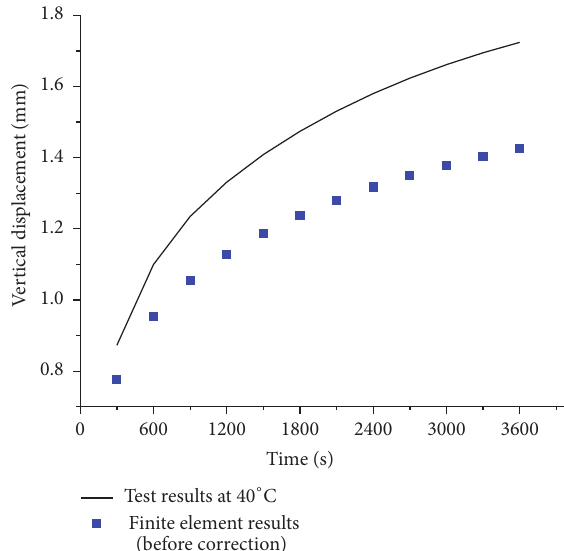
Figure 5: Comparison between the finite element results and the experimental results before correction (40 ∘ C).